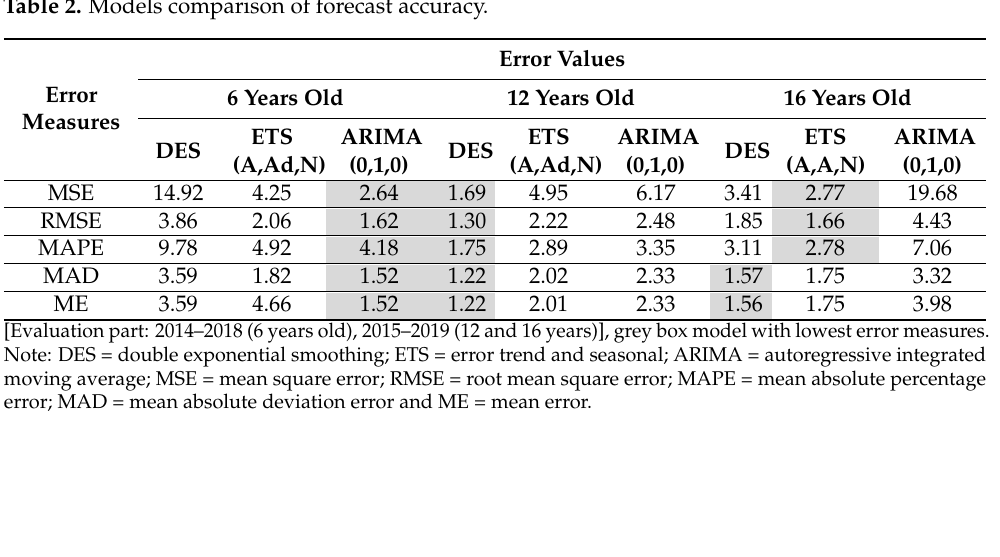
Table 2. Models comparison of forecast